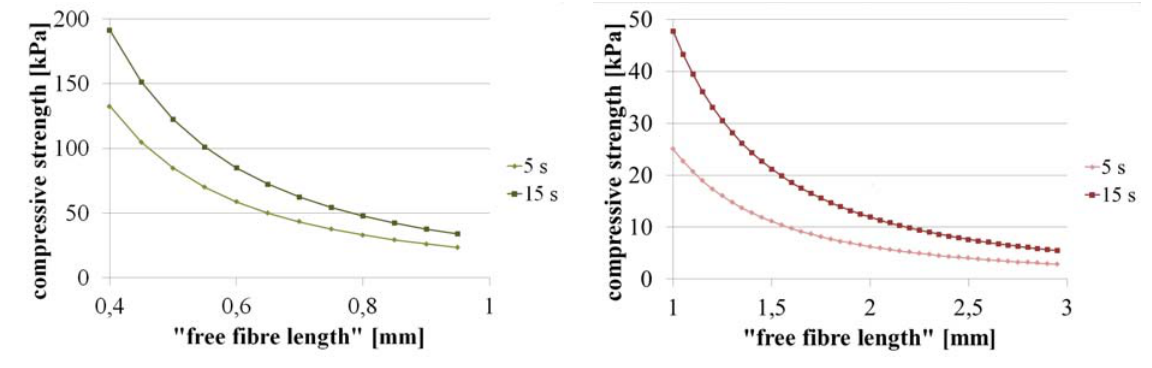
Figure 5. Calculated compression strength for the different flock scaffolds as a function of the “free fiber length”. ( a ) 1 mm fibers; ( b ) 3 mm